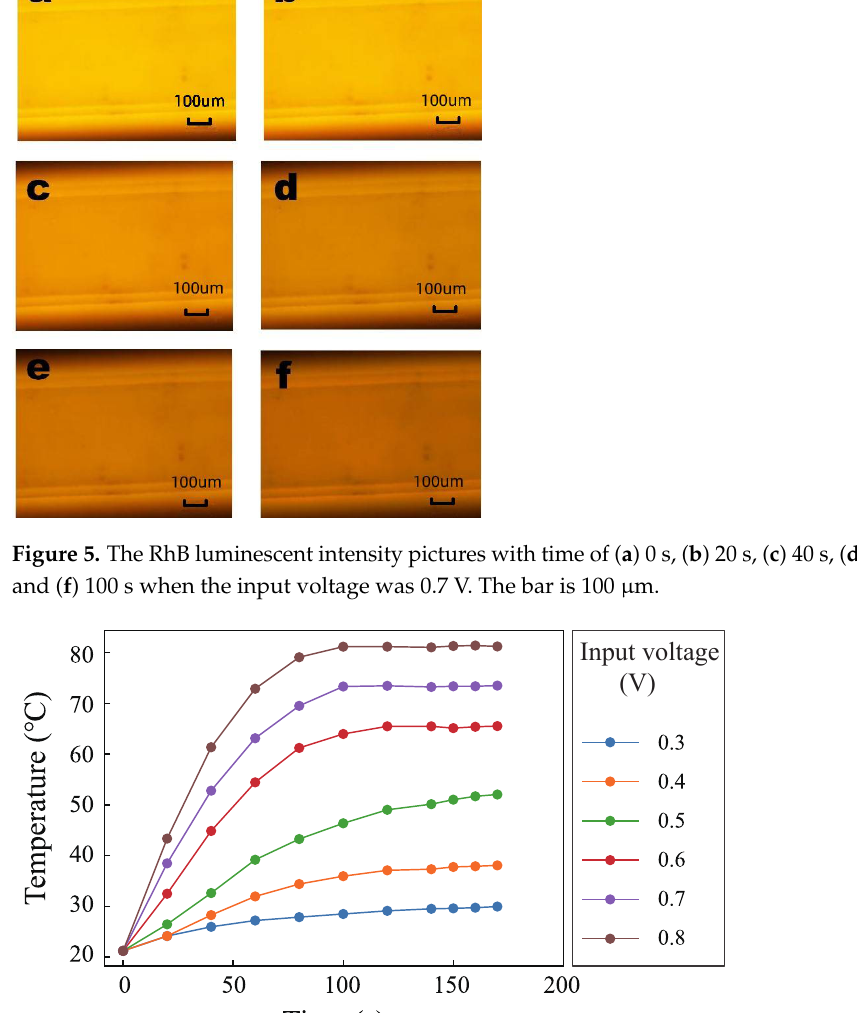
Figure 6. Fluid temperature changing with time when the input voltages are 0.3 V, 0.4 V, 0.5 V, 0.6 V, 0.7 V, 0.8 V.